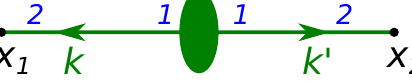
Figure 1 . Scalar particle production as envisioned here, with the solid lines denoting colliding quarks in the two nuclei and the dashed line denoting the scalar particle. The shaded circle may represent a quark loop, as would be the case in the Higgs production.